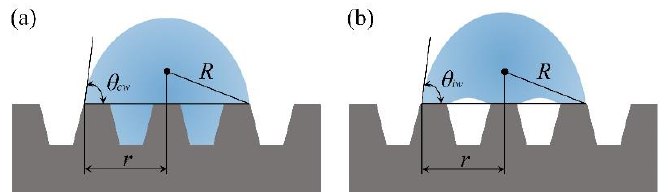
Figure3. Wettingmodelontrapezoidalgroovestructure: ( a )completewettingmodeland( b )incomplete Figure 3. Wetting model on trapezoidal groove structure: ( a ) complete wetting model and ( b ) wetting incomplete wetting model.